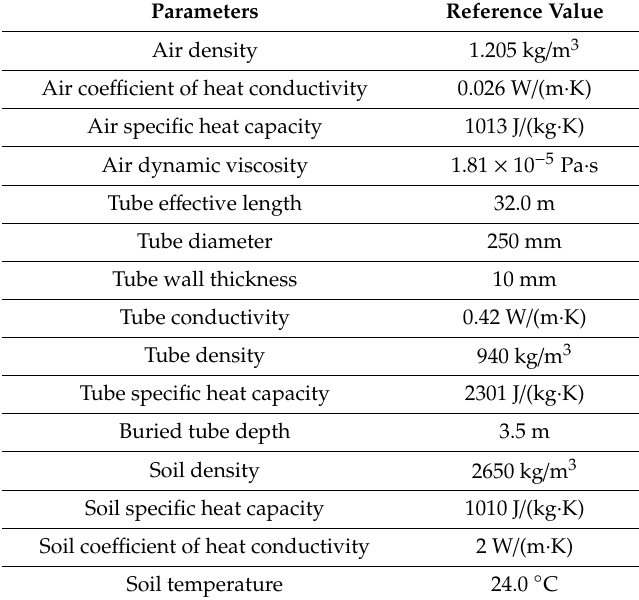
Figure 4. Schematic diagram of underground air tunnel (UAT) system. Table 1. Input parameters for model validation.